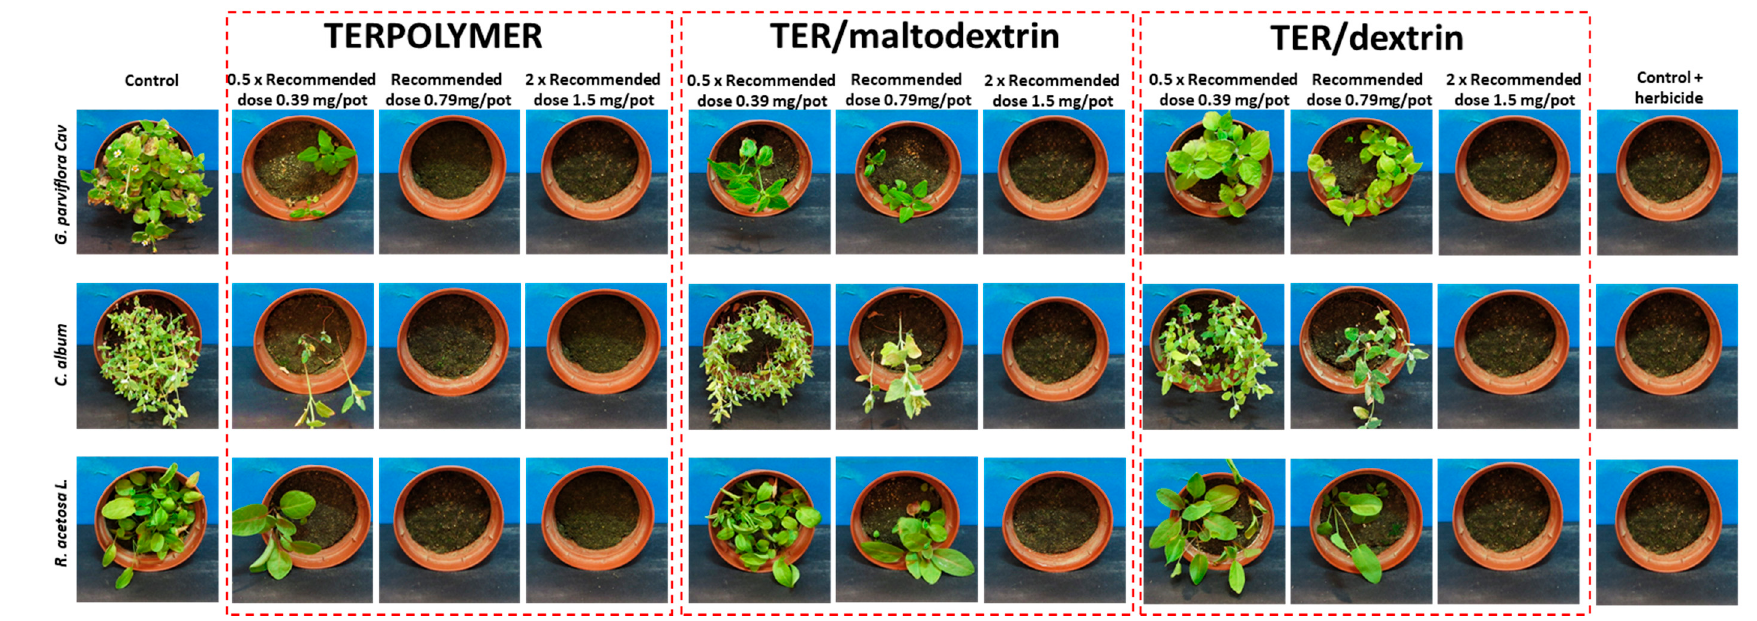
Figure 8. Herbicidal activity assessment of released metazachlor from microspheres after one month of incubation of microspheres in soil. Table 2. Herbicidal activity assessment of metazachlor released from microspheres after one month of their incubation in soil (European Weed Research Council (EWRC) scale. Herbicides were loaded in three doses: half of recommended (0.39 mg / pot), recommended (0.79 mg / pot) and double dose (1.5 mg / pot). TERPOLYMER TER/Maltodextrin TER/Dextrin